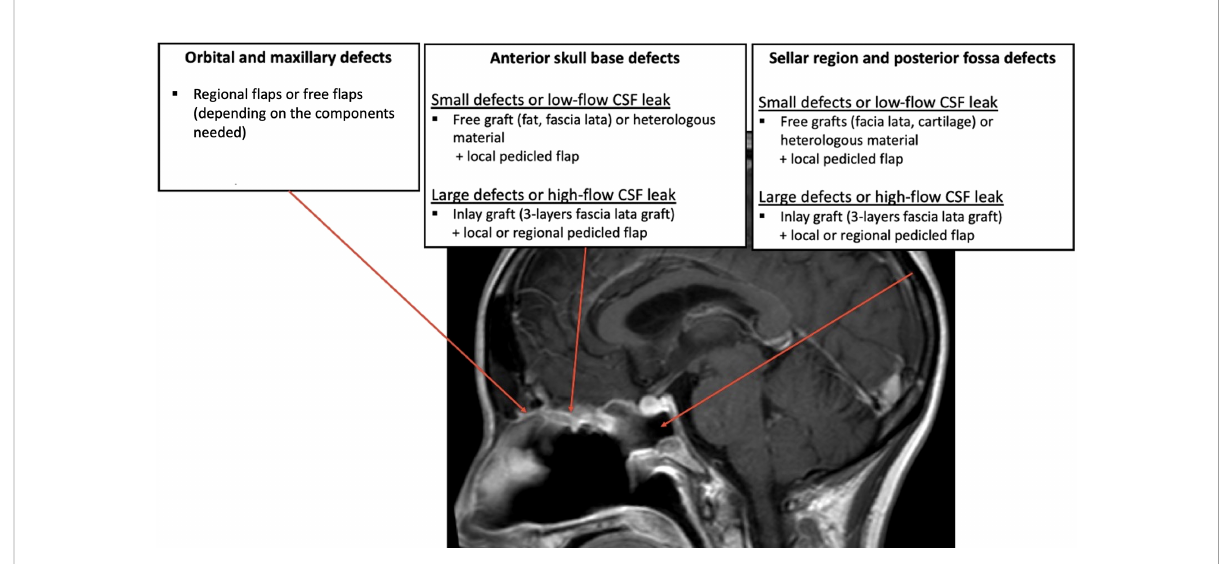
FIGURE 6 A proposition for reconstruction strategies according to the location and size of the defect after surgical removal of the